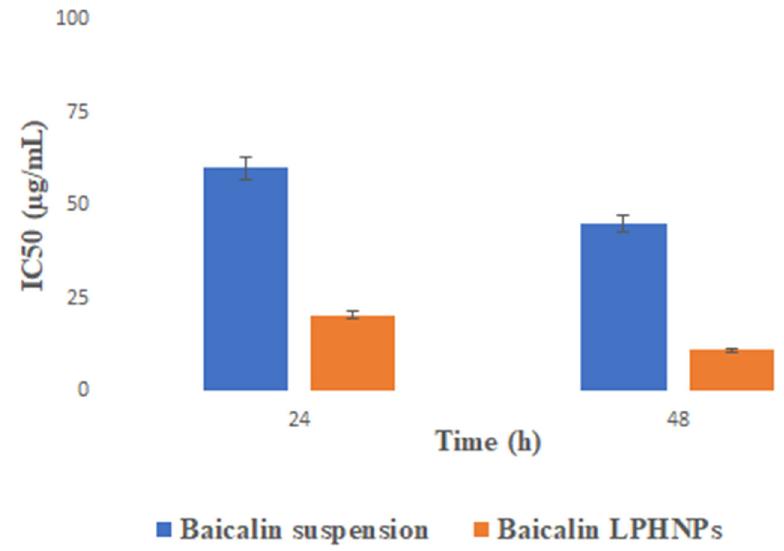
Figure 6. IC 50 of baicalin suspension and baicalin-loaded LPHNPs. The data showed significant ( p < 0.05) cytotoxicity compared to BQ-loaded suspension, after 24–48 h. All data expressed as mean ± SD ( n = 3). Blank suspension and blank LPHNPs observed no toxicity in the duration of 24–48 h up to a concentration of 100 μ g/mL. IC 50 = half maximal inhibitory concentration.